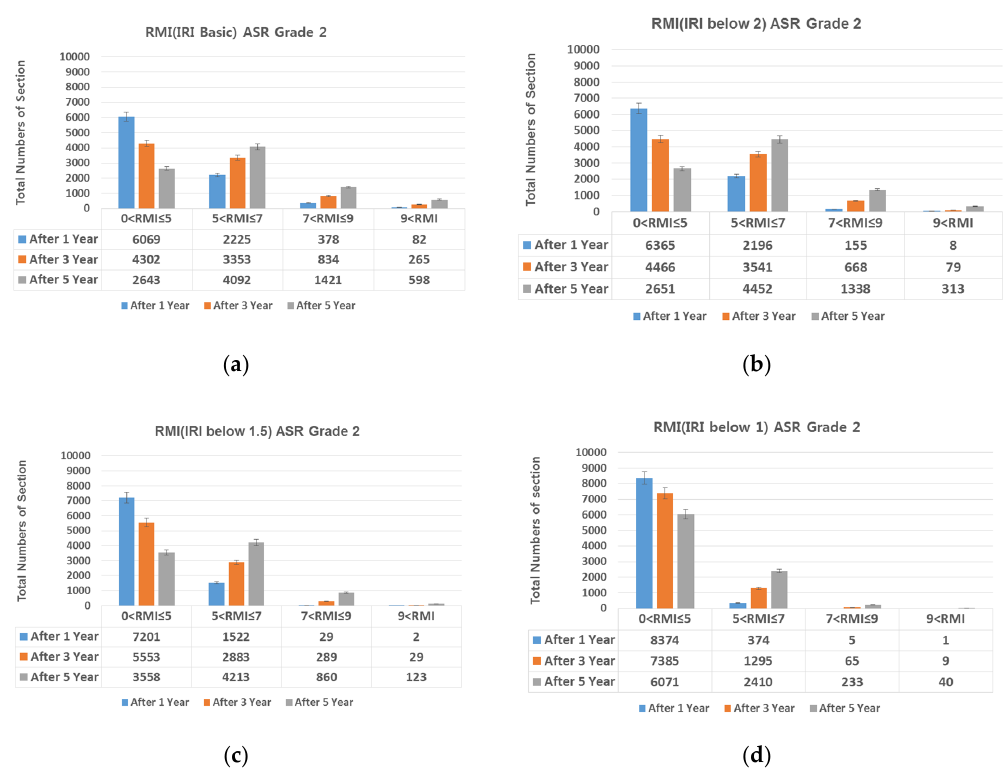
Figure 12. Change in number of sections per RMI with respect to IRI. ( a ) basic IRI and ASR grade 2; ( b ) IRI 2.0 and ASR grade 2; ( c ) IRI 1.5 and ASR grade 2; and ( d ) IRI 1 and ASR grade 2.